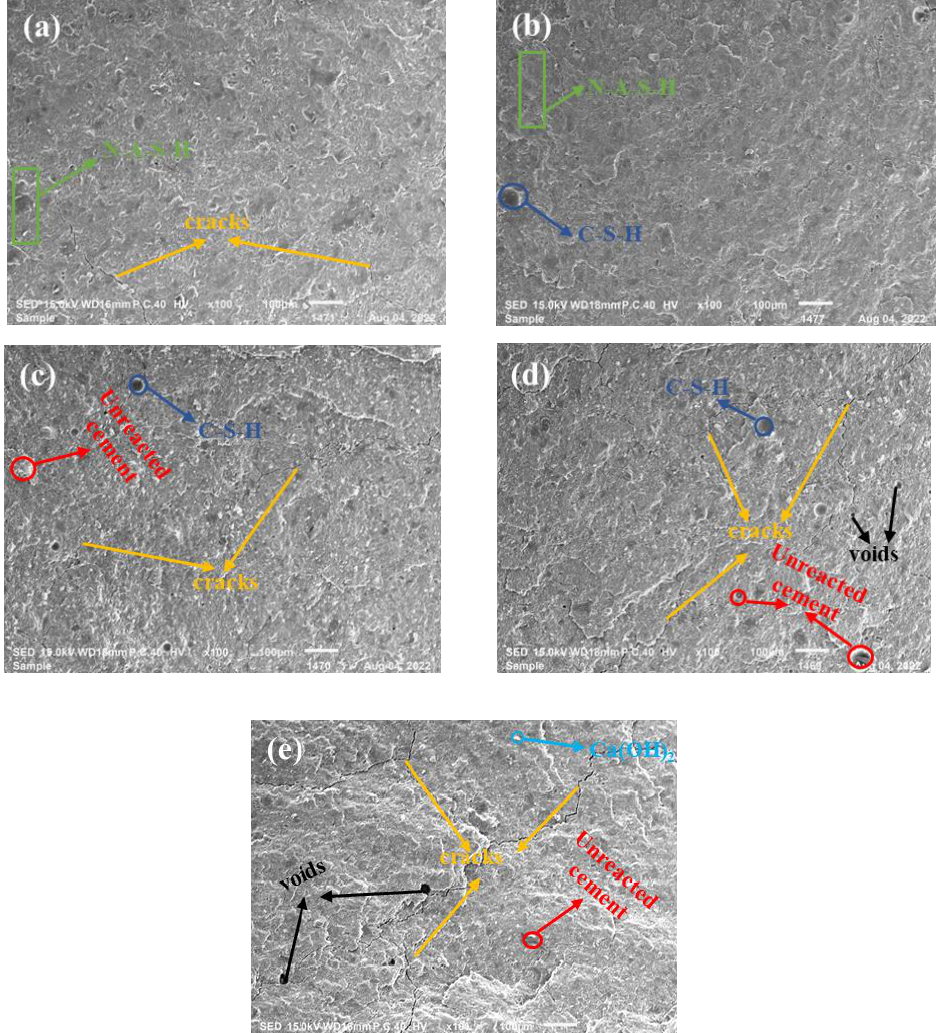
Figure 5. SEM of the geopolymers containing different proportions of CEM I: ( a ) G 0 ; ( b ) G 5 ; ( c ) G 10 ; ( d ) G 20 ; and ( e ) G 30 .